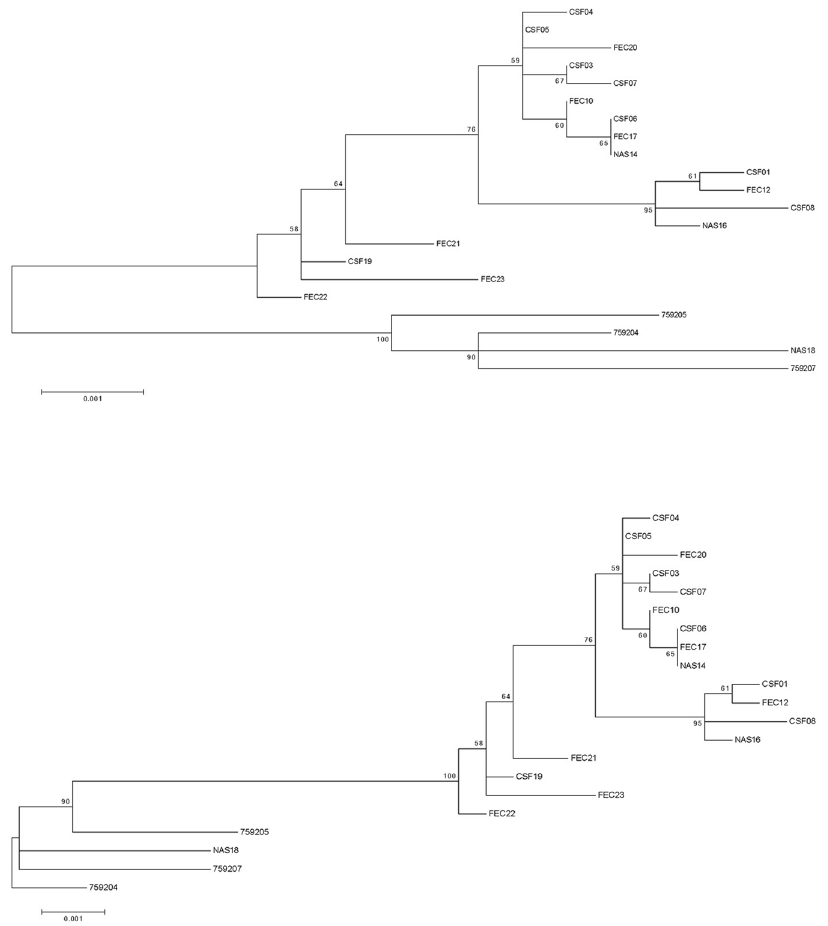
Figure 1. Maximum Likelihood (ML) phylogenetic tree based on the capsid encoding region from nucleotide 701–3013 of the 18 Australian HPeV3 sequences together with the closest related Yamagata 2011 virus sequences. Sequences were aligned using Clustal W and phylogenetic analysis was conducted using MEGA 6 and the Maximum Likelihood (ML) method based on the Tamura-Nei model 51 . The tree with the highest log likelihood is shown. Bootstrap test involved 1000 replicates to determine reliability of the inferred tree. The numbers at nodes represent bootstrap values. Branch lengths are scaled according to the numbers of nucleotide substitutions per site. Details of the samples are given in Table 1 and in the text. Samples 759204, 759205 and 759207 are the closest related Yamagata 2011 lineage virus sequences and taken from NCBI with the corresponding accession numbers: AB759204, AB759205, AB759207. Based on information from AB759206 (HPeV3 Yamagata 2011 lineage 39 ), the structural/capsid coding region is from nucleotide 701–3013 and